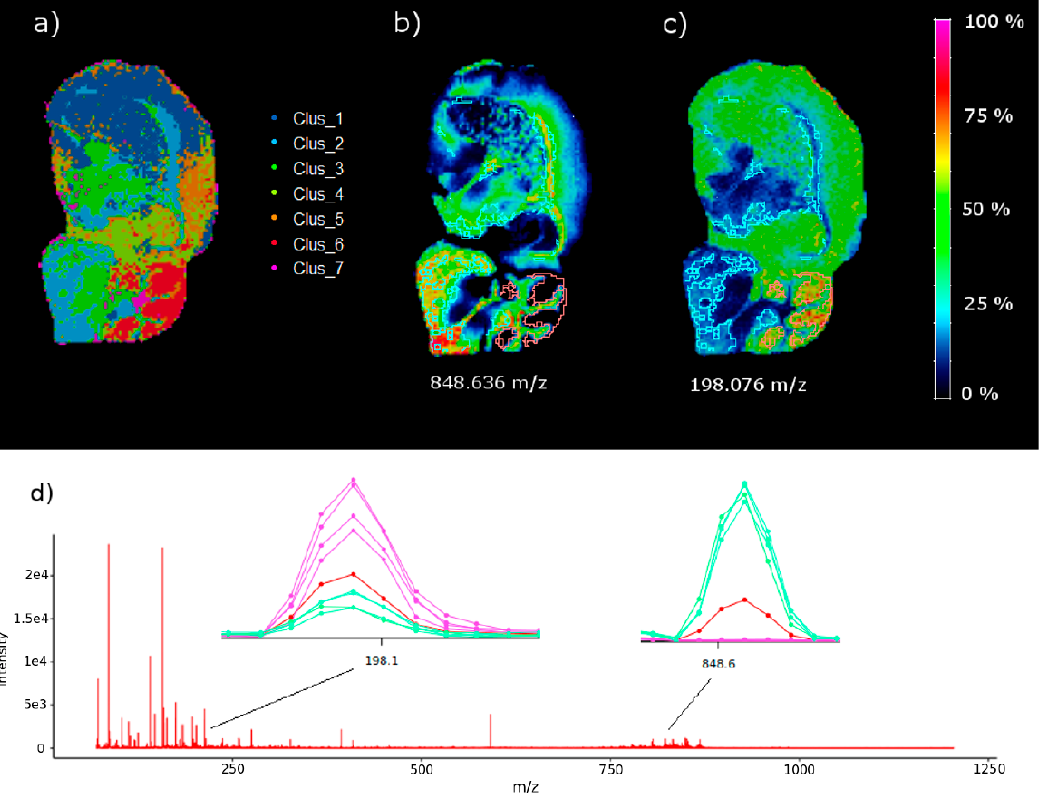
Figure 3. ( a ) Mouse brain segmentation using k-means (n = 7 clusters), ( b ) intensity map of ion m / z 848.636 (the up-regulated ion in C2 versus C6 with the highest contrasting parameter extracted from the null concentration parameter) and ( c ) intensity map of ion m / z 198.076, the down-regulated ion with the highest contrast parameter after comparing C2 and C6, extracted from the volcano plot. The highlighted areas in ( b , c ) represent C2 (white contour) and C6 (red contour). ( d ) Mean spectrum (red), spectra from C2 pixels (green), and spectra from C6 pixels (pink) near m / z 848.636 and m / z 198.076. The spectra show the up-regulated and down-regulated behaviour of the ions. See also the optical image of the same brain tissue section stained with a Hematoxilyn in Figure